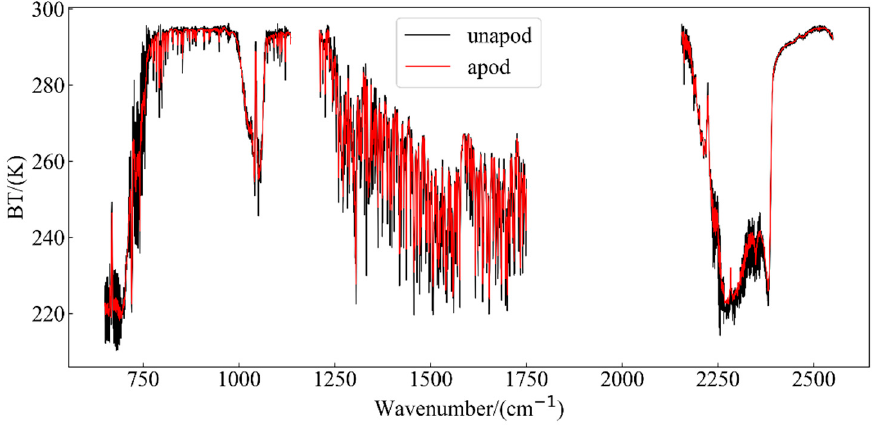
Figure 7. Spectral brightness temperature apodization before and after